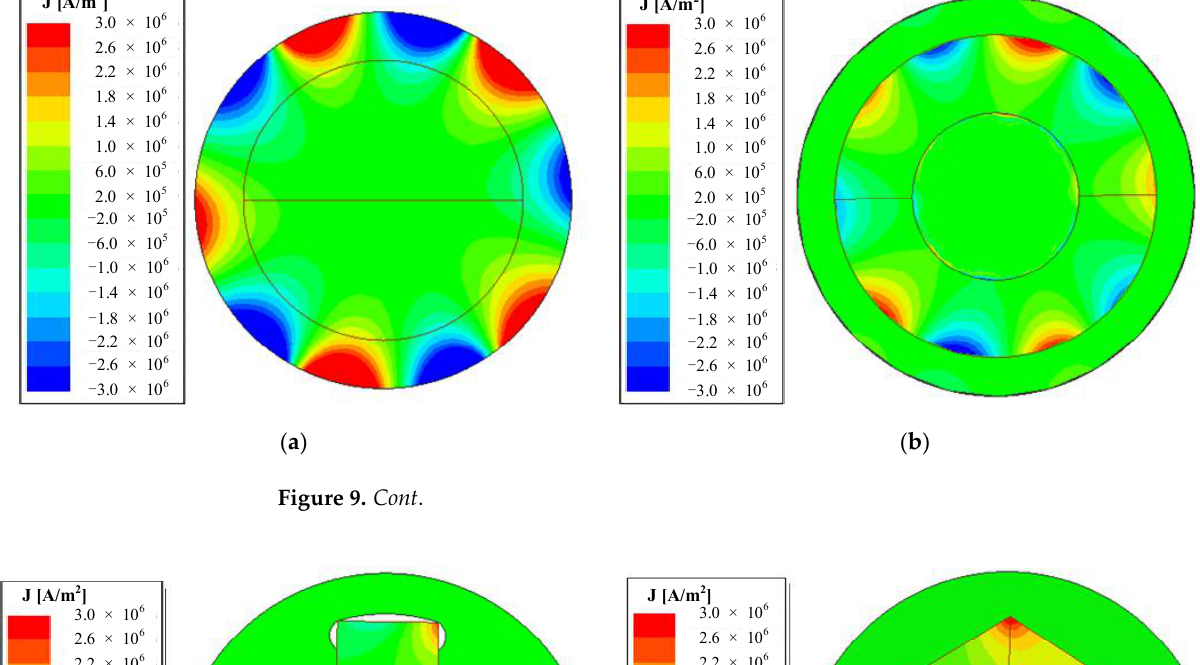
h t /δ Figure 8. k sp versus ratio of wire thickness to skin depth at different frequencies.